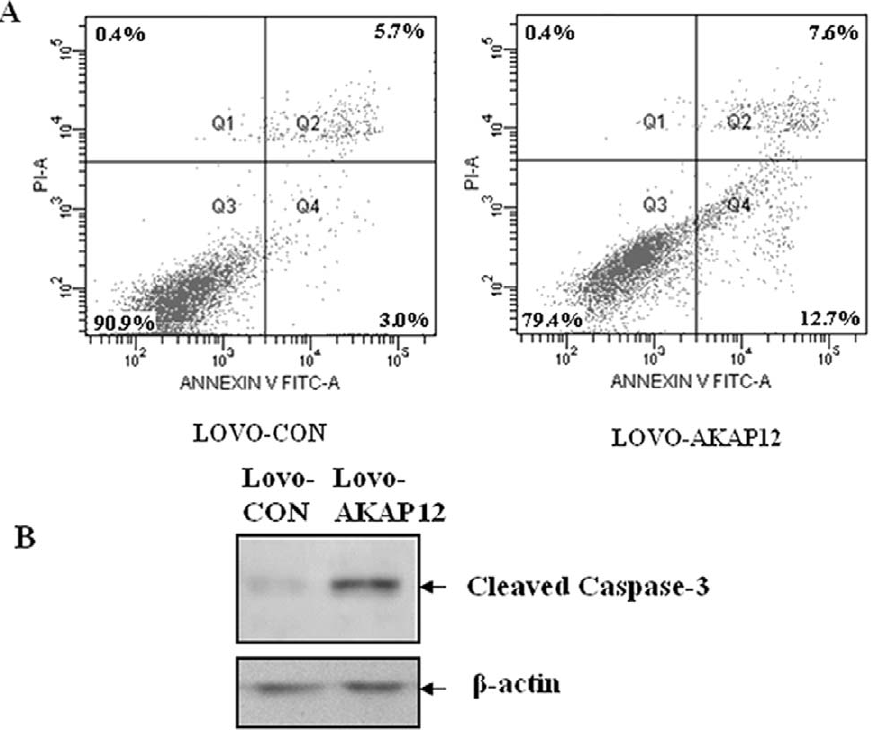
Figure 1. Effects of AKAP12 on apoptosis of LoVo cells transfected with pCMV6-AKAP12. (A) Effects of AKAP12 expression on apoptosis in AKAP12-transfected LoVo cells. LoVo-AKAP12 cells and LoVo-CON cells were analyzed using FACS and PI/Annexin V staining. The legends show the percentage of cells undergoing apoptosis. (B) Western blot analysis of cleaved-caspase-3 in Lovo-CON and Lovo-AKAP12 cells. AKAP12 increase cleaved-caspase-3 in cultured Lovo